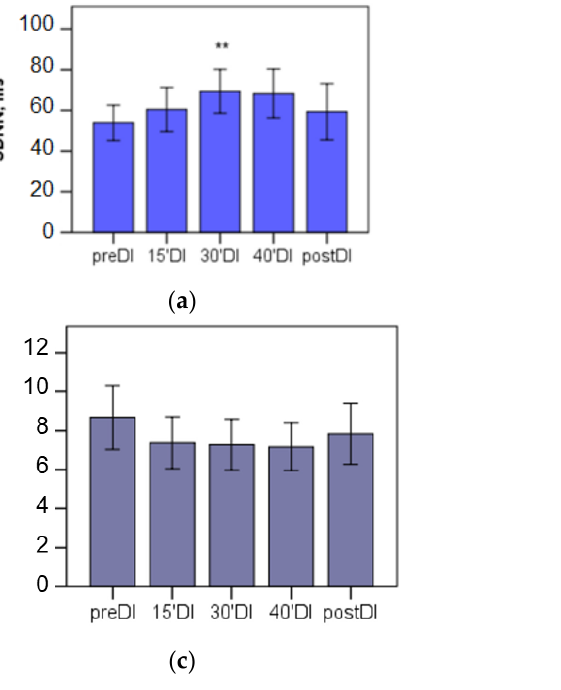
Figure 2. Time- and frequency-domain HRV parameters in subjects during “dry” immersion sessions. Horizontal axis depicts study points: before (baseline test—preDI), on the 15, 30, 40 min DI session (15 ′ DI, 30 ′ DI and 40 ′ DI, correspondingly), and 3 min after DI (postDI). ( a ) SDNN, ms; ( b ) pNN50, %; ( c ) Stress index; ( d ) HRV spectrum structure. The difference from the baseline condition: * p < 0.05, ** p < 0.01. Table 3. Nonlinear results of heart rate variability analysis in subjects during the DI session. postDI